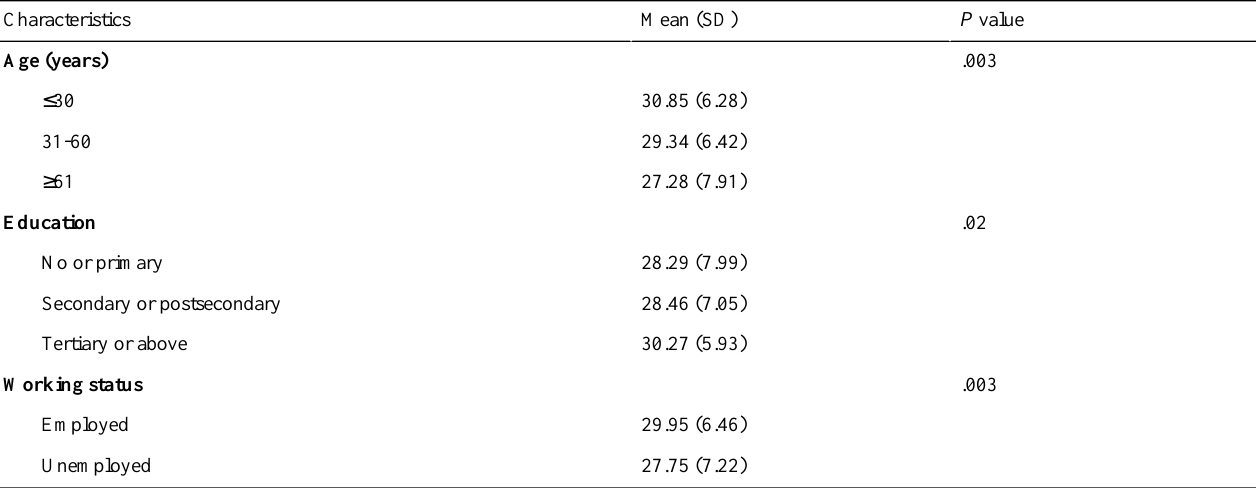
Table 4. Known-group validity of the simplified Chinese eHealth literacy